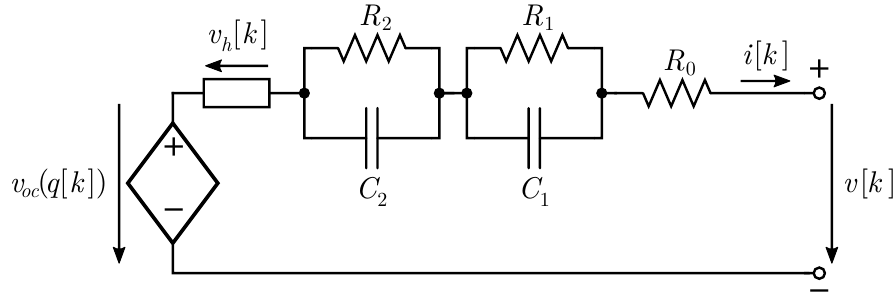
Figure 2. Equivalent circuit model with two RC elements and hysteresis similar to